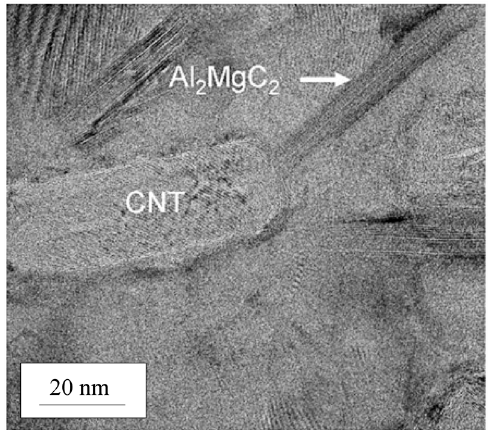
Figure 20. TEM image of (Mg-6 wt % Al)/CNT interface, indicating the in situ formation of